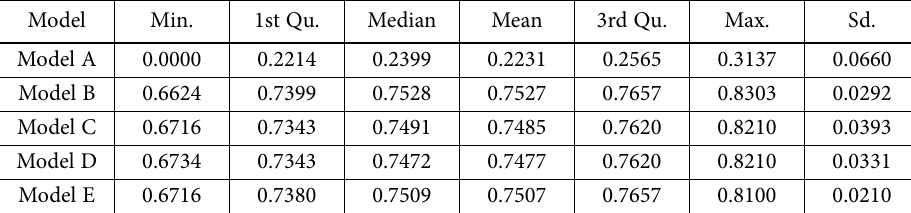
Table 6. Analysis of the hit ratio (HR) for the different prediction models Model Min. 1st Qu. Median Mean 3rd Qu. Max. Sd. Model